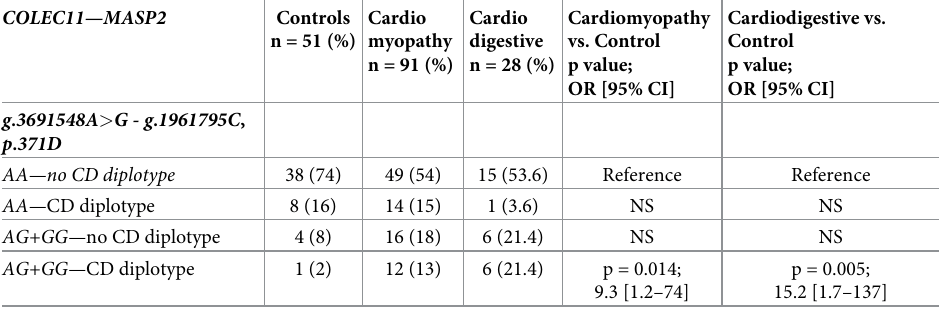
Table 6. Gene-gene interaction: COLEC11 and MASP2 genotypes frequencies in patients with chronic CD and healthy controls.